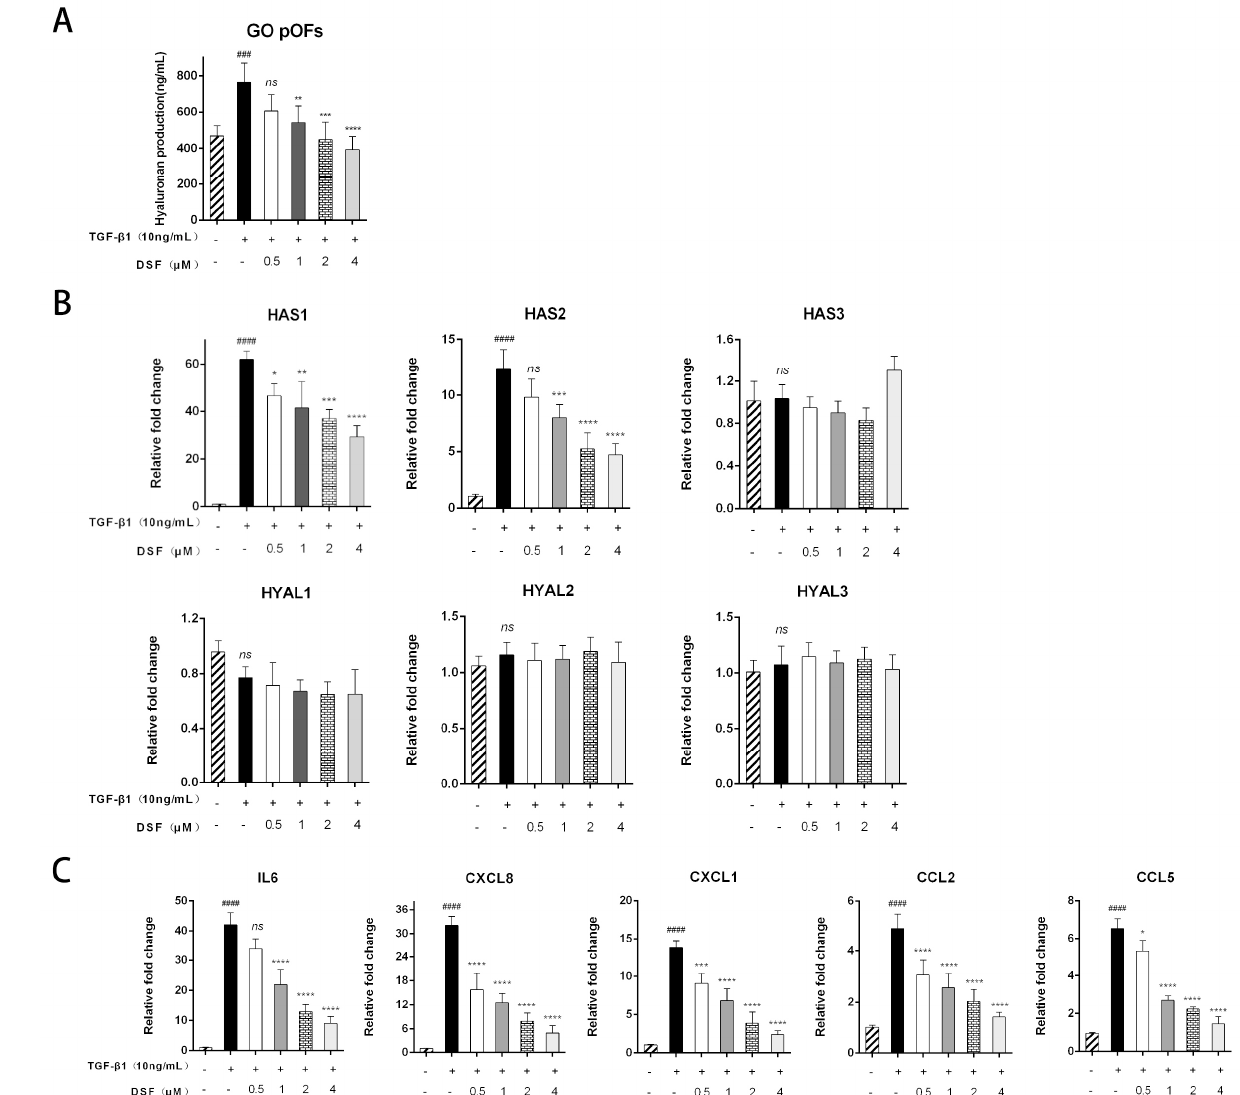
Figure 4. DSF attenuates HA production and suppresses inflammatory molecule expression. ( A ) The concentrations of HA in the GO pOF cell supernatants were quantified by ELISAs. ( B ) mRNA expression levels of HAS1, HAS2, HAS3, HYAL1, HYAL2, and HYAL3. ( C ) mRNA levels of IL-6, CXCL8, CXCL1, CCL2, and CCL5. Each graph shows the mean ± SD of repeated experiments from at least 3 patients. ### p < 0.001, #### p < 0.0001 compared with the control; * p < 0.05, ** p < 0.01, *** p < 0.001, and **** p < 0.0001 compared with TGF- β 1 alone; ns denotes no statistical significance versus the control/TGF- β